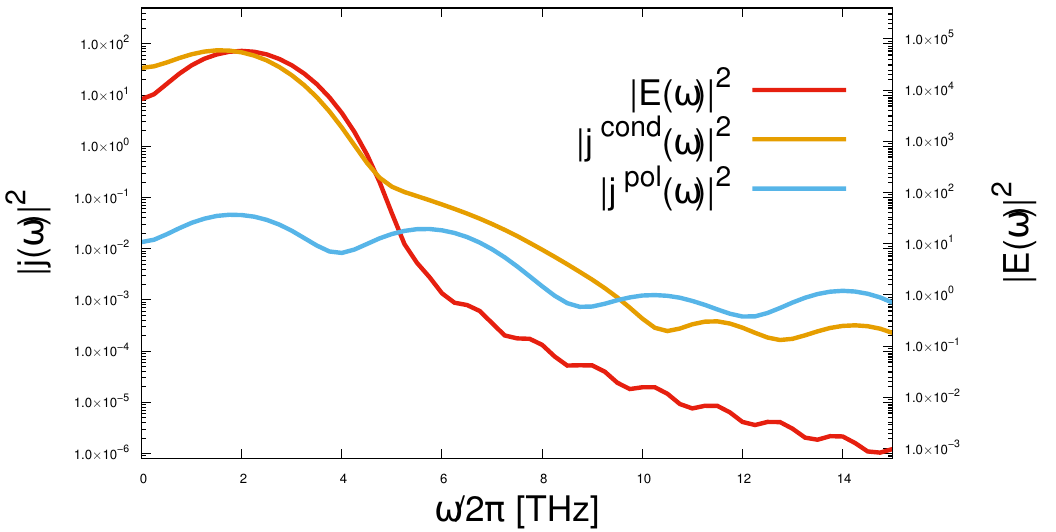
Figure 13. Periodograms for the pulse of a periodic electric field (Figure 5) and the currents generated by it (Figure